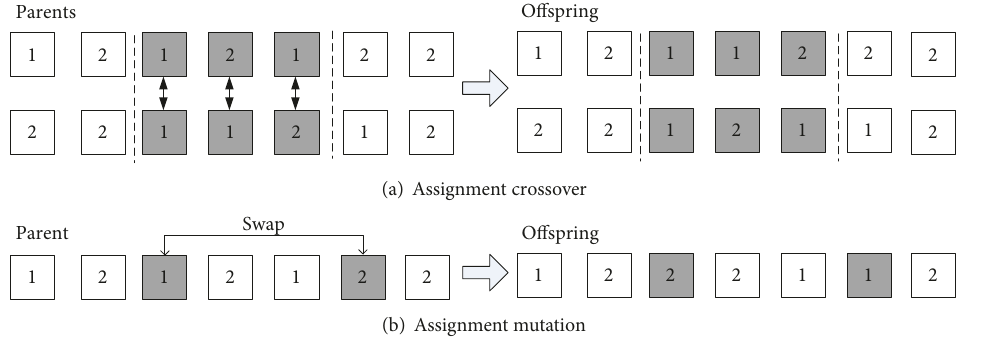
Figure 5: Example of assignment operators.